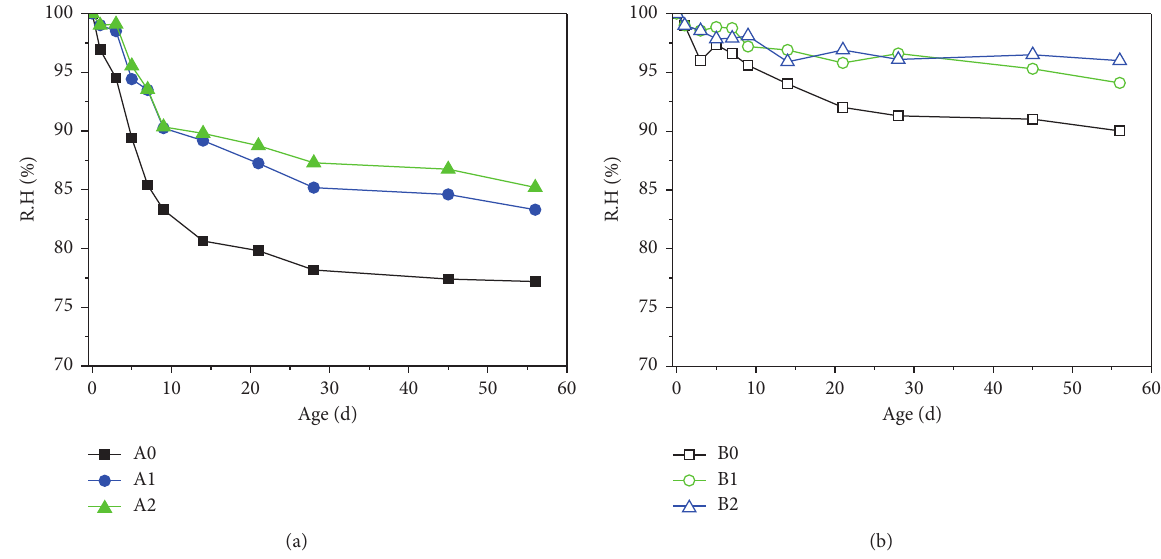
Figure 6: Relationship between IRH and age of concrete. (a) Concrete without FA; (b) concrete with FA.